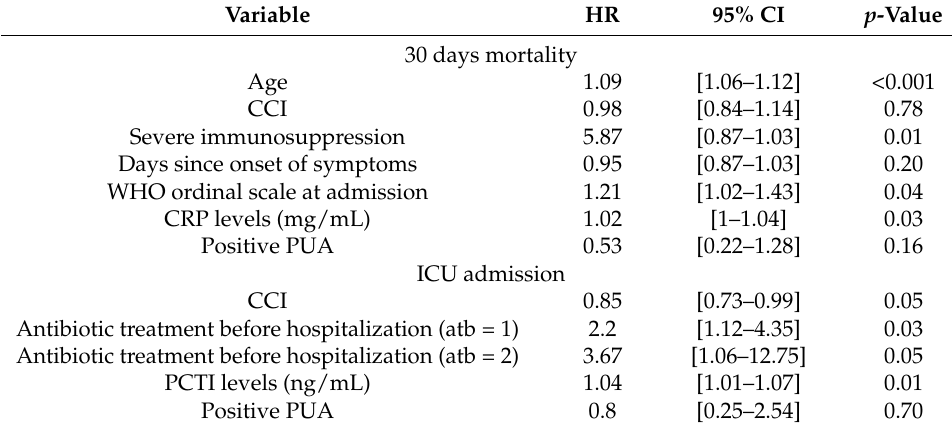
Table 2. Multivariate Cox regression for 30-day mortality and ICU admission.